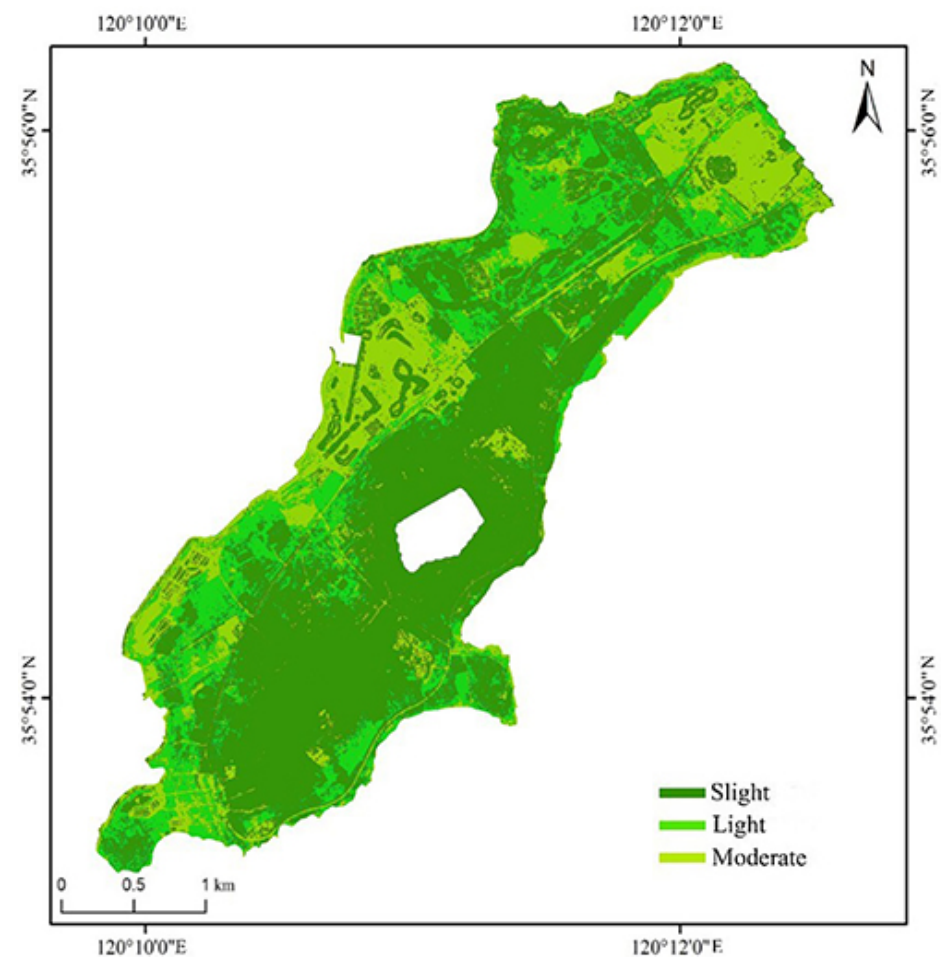
Figure 8. Spatial distribution map of soil erosion